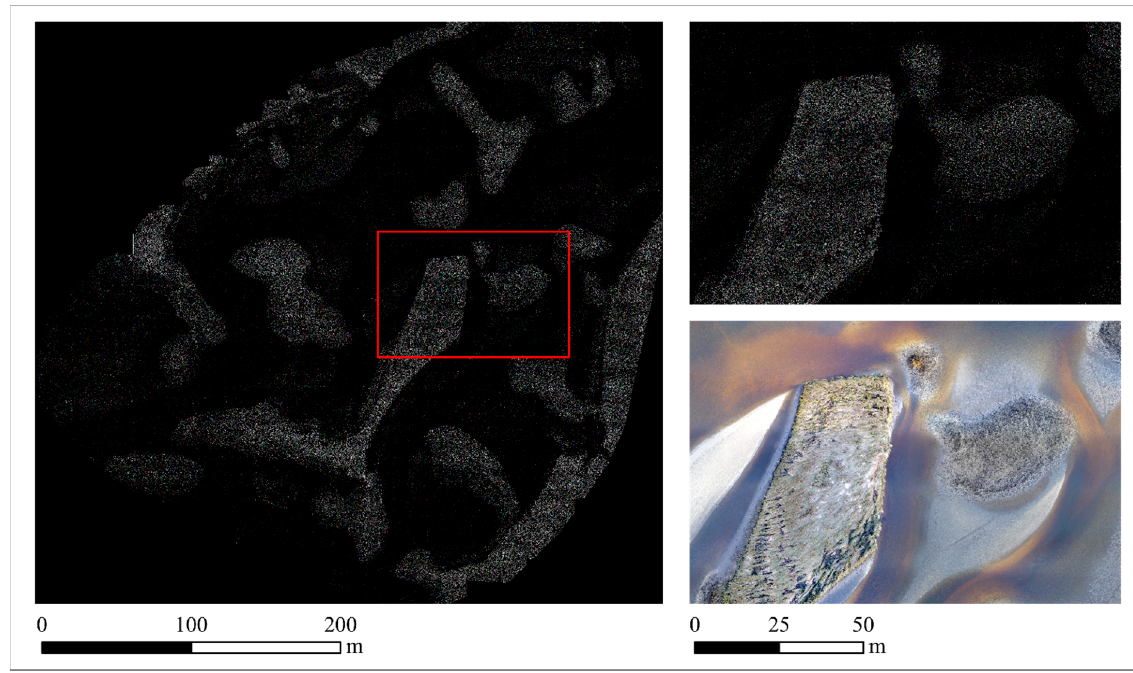
Figure 6. Laplacian filter ( left ) used for edge detection with a detailed section ( top right ) and its corresponding area on the orthomosaic ( bottom right ). The red rectangle represents the extent of the detailed section. Table 1. Object features that allow for the most separation in classes at each dimension with the corresponding separation value. Dimension refers to the number of object features contributing to the separation analysis. The higher the separation value, the greater the di ff erentiation between the classes as represented by the randomly selected